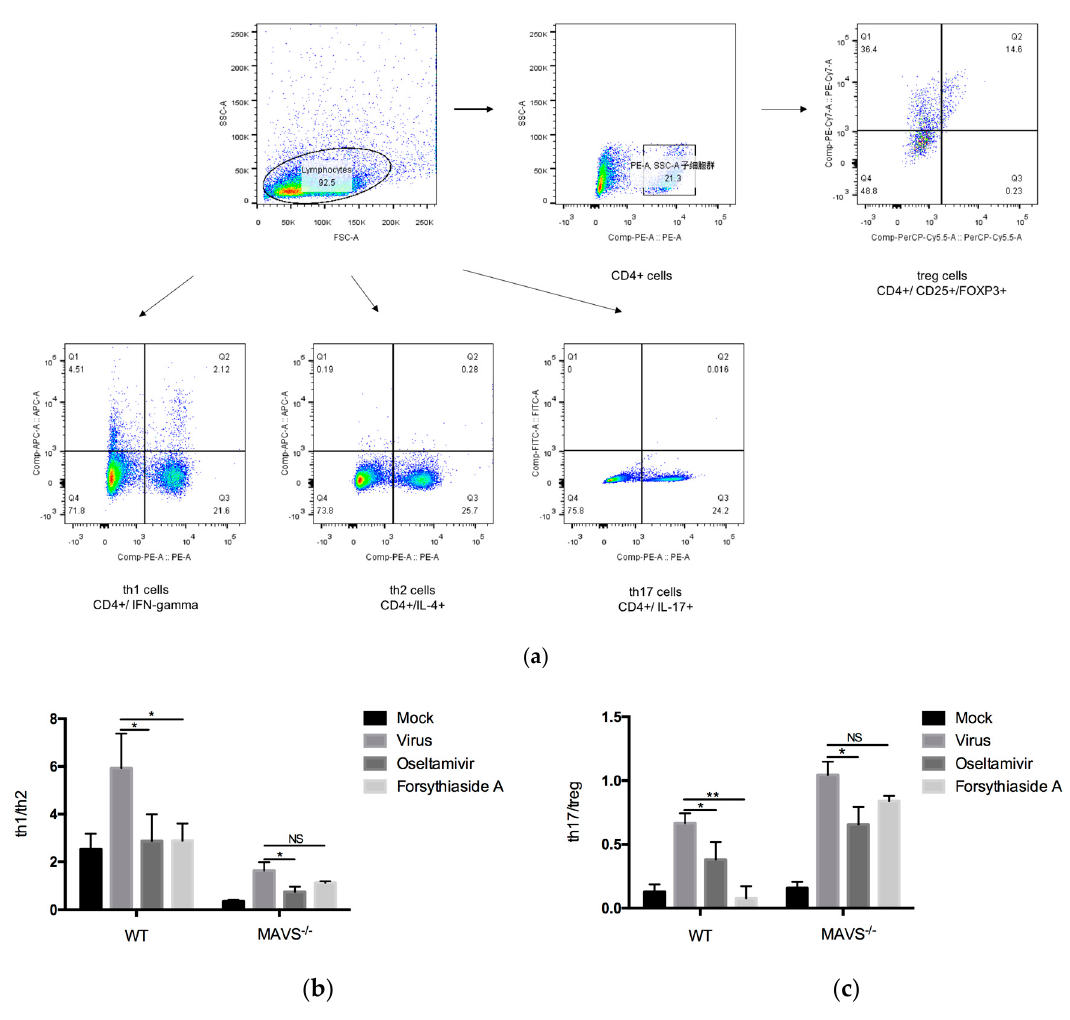
Figure 8. Flow cytometry for detection of Th1 / Th2 and Th17 / Treg in CD4 + T cell subsets at day 6 post infection. ( a ) represents flow cytometry analysis of Th1, Th2, Th17, and Treg cell subsets. ( b ) and ( c ) represent the ratio of Th1 / Th2 and Th17 / Treg cell subsets ( n = 6). * p < 0.05, ** p < 0.01, *** p < 0.001, NS, p > 0.05.